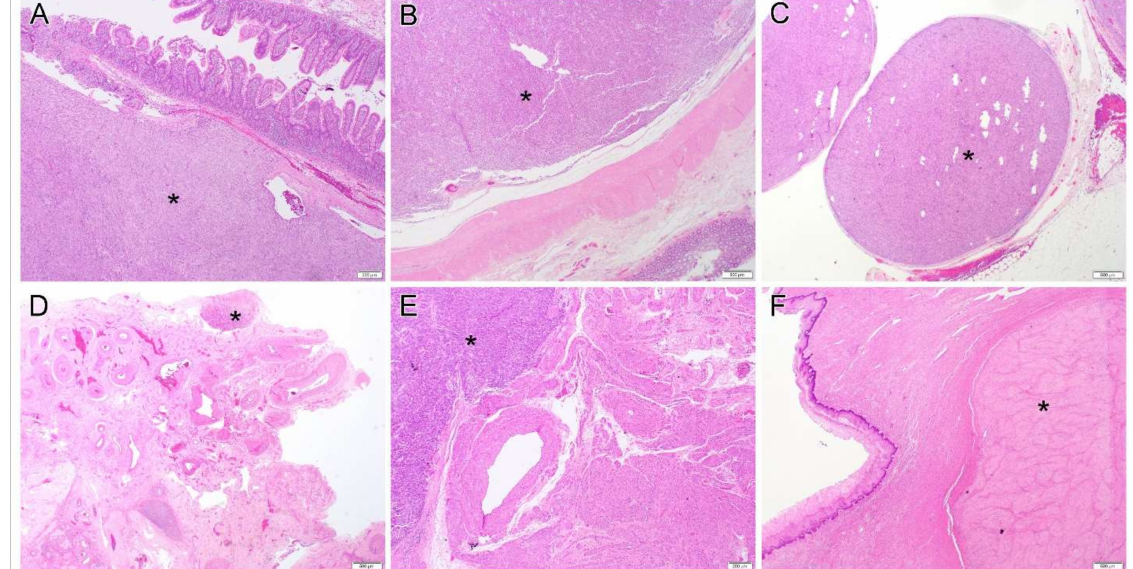
Figure 1. ( A – C ). Gastrointestinal stromal tumor originates/involves small bowel ( A , case 4), colon ( B , case 2) and omentum ( C , case 13). ( D – F ). Representative pictures of gynecologic organ involve- ment: periovarian tissue ( D , case 4), uterus ( E , case 17) and vagina ( F , case 15). Star (*) indicates the tumor. Original magnification: ( A , E ), × 40; ( B – D , F ), ×